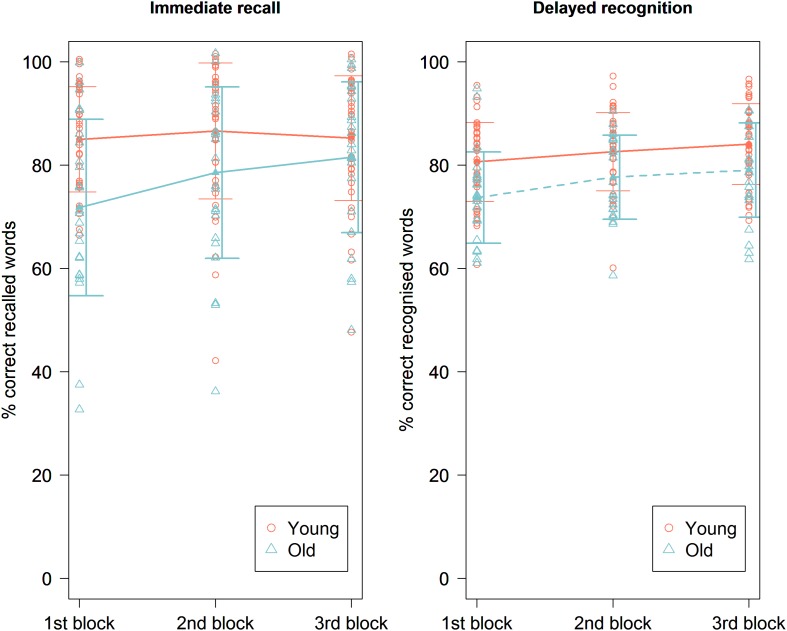
Immediate recall (left) and delayed recognition (right) accuracy scores in percentage during the three blocks of the experimental session for the young and the old group. A significant effect of order was seen on immediate recall scores in the old age group and on delayed recognition scores in both age groups, showing significantly higher scores toward the end of the paradigm. Line plots represent mean scores. Error bars represent standard error.